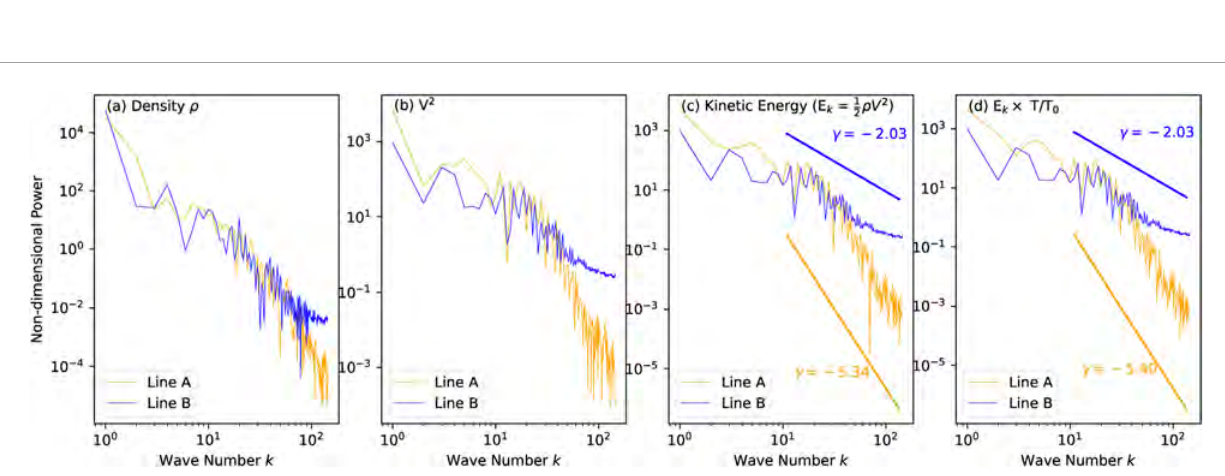
weighted E in according to the chosen temperature (log T ∼ 7 . 05 k